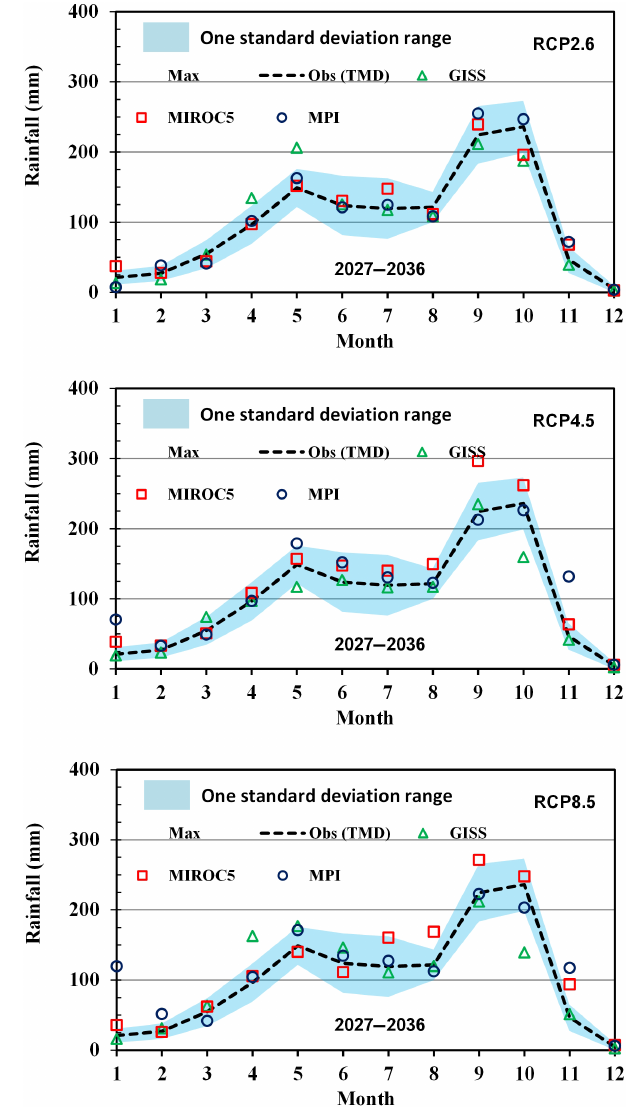
Figure 6. Comparison of mean monthly temperature variation dur- ing the periods of 2017–2026 (under the climate change scenarios) and